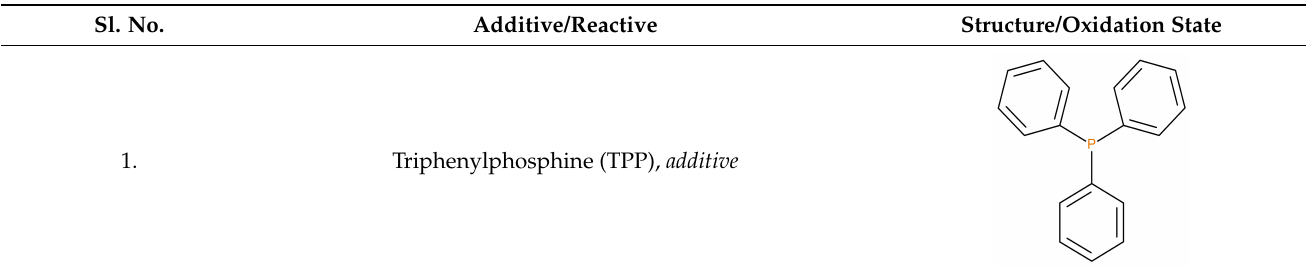
Table 1. The additives and reactives used for the bulk polymerization of MMA. Sl. No. Additive/Reactive